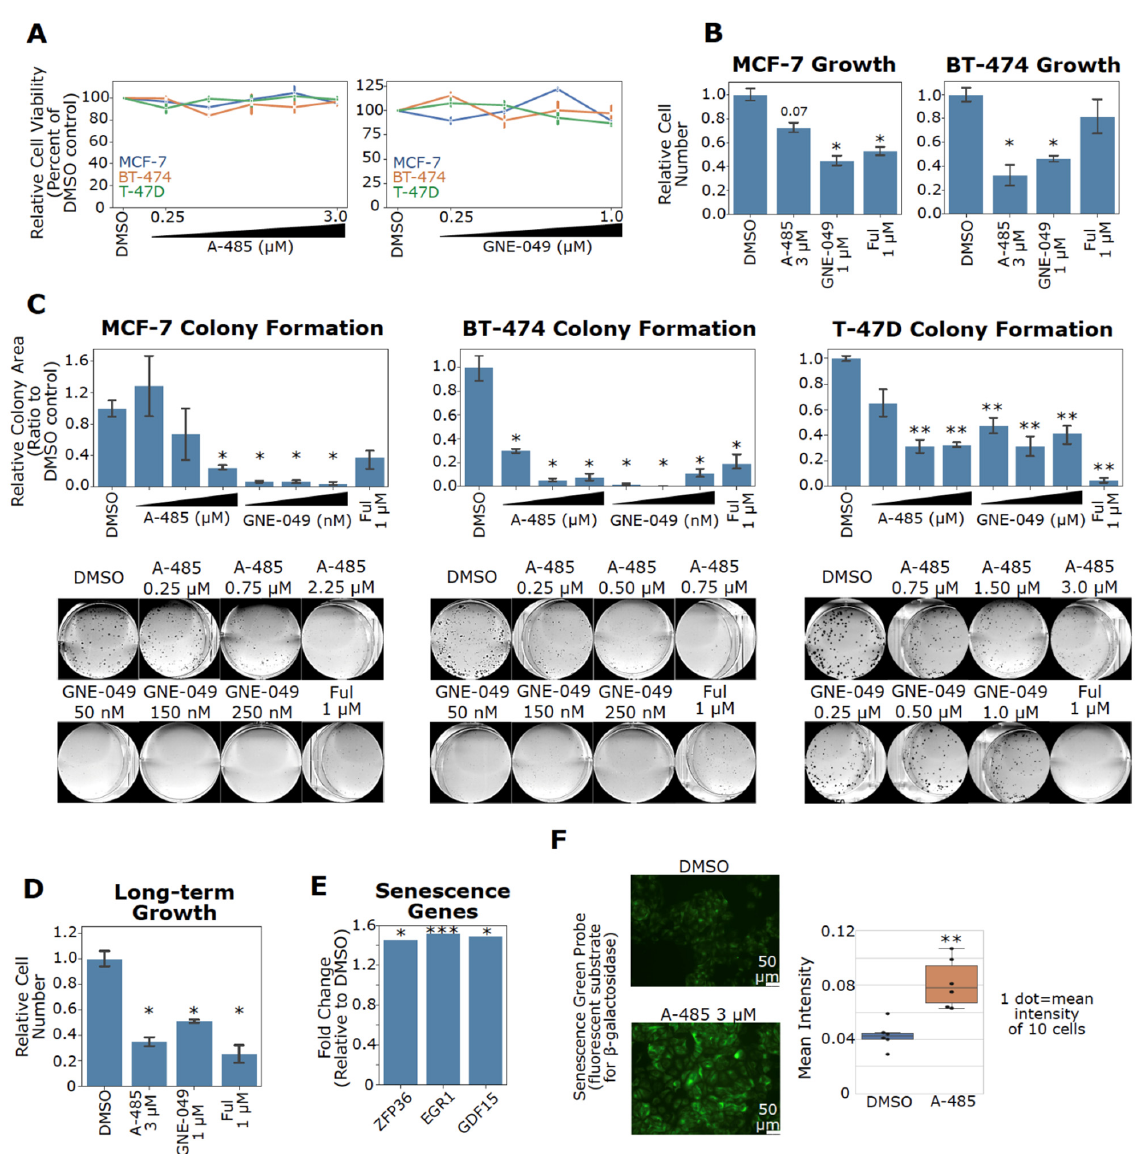
Figure 7. CBP/p300 inhibitors A-485 and GNE-049 suppress cell growth and induce senescence of ER+ BC cells. ( A ) CBP/p300 inhibitors do not acutely reduce cell viability in ER+ BC cells. MCF-7, T-47D, and BT-474 cells were treated with A-485 and GNE-049 at the indicated concentrations for 96 h. Cell viability was measured with Cell-TiterGlo. ( B ) CBP/p300 inhibitors block cell proliferation in ER+ BC cell lines. MCF-7 and BT-474 cells were treated with the indicated concentrations of A-485 and GNE-049 for 8 days. Cell numbers were then counted and the relative cell numbers are shown (normalized to the DMSO control, n = 3). ( C ) CBP/p300 inhibitors potently suppress colony formation in ER+ BC cell lines. MCF-7, BT-474 and T-47D cells were treated with the indicated concentrations of A-485 and GNE-049. Colonies were allowed to grow for between 2–3 weeks. Colony area was measured by ImageJ plugin ColonyArea and normalized to the DMSO control ( n = 3). Representative colony images for each cell line are shown below. ( D ) Long-term CBP/p300 inhibition retards cell growth after drug washout. MCF-7 cells were treated as in ( B ) for 8 days. Cells were then counted, re-seeded and allowed to grow for 9 days in the absence of drugs. The relative growth of drug treated cells vs DMSO control from three independent experiments ( n = 3) is plotted. ( E ) A-485 upregulates senescence-associated genes in MCF-7 cells. Data are from the microarray experiment. Fold changes of these genes are plotted. ( F ) A-485 induces senescence in MCF-7 cells. MCF-7 cells were treated with A-485 for 8 days. Cells were then counted and re-seeded in 96 well plates. At 24 h after reseeding, cells were stained for β -galactosidase activity and mean intensity of staining was quantified. Representative images of two independent experiments ( n = 2) are shown. In the bar graph in panel G, *: p < 0.05; **: p < 0.005; ***: p < 0.0005 (Student’s t- t est).